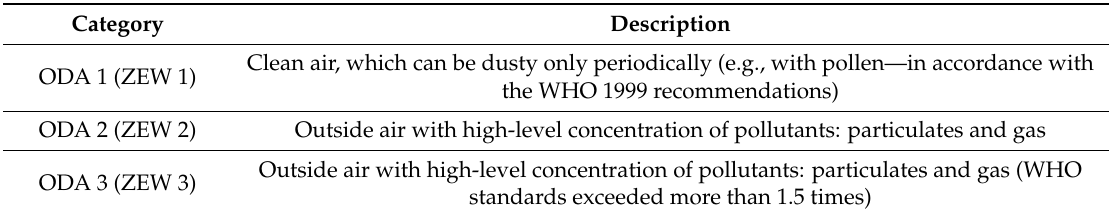
Table 1. Outside air classification based on PN-EN 13779